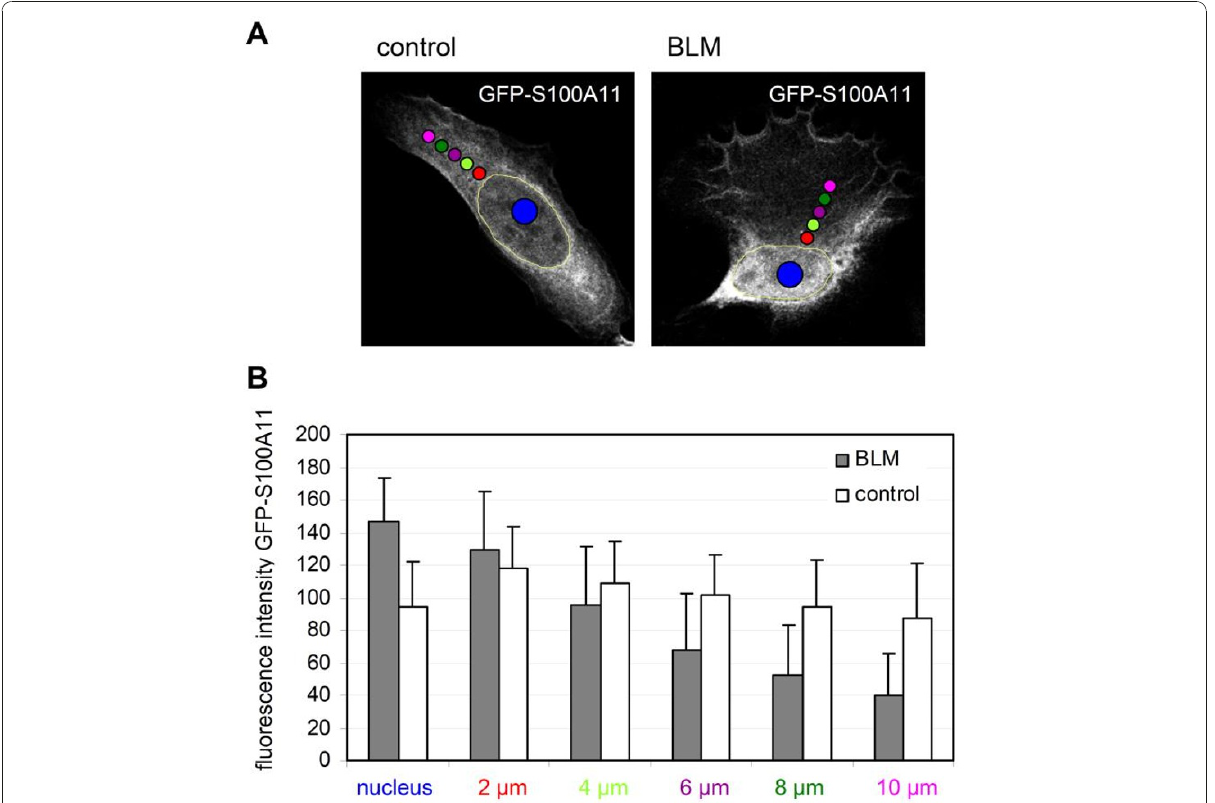
Figure 2 Quantification of S100A11 translocation in stress stimulated cells . The translocation of GFP-S100A11 in U-2 OS cells which were treated with BLM for 30 min to induce DNA double strand breaks (DSB) or in control cells was quantified by measurement of the average GFP- S100A11 fluorescence intensity in different areas within the cytoplasm as well as in the nucleus using MetaMorph analysis software as described in Materials and Methods. (A) The fluorescence intensity of GFP-S100A11 in five cytoplasmic areas (2 μ m diameter each; stained in red, light green, violet, green and pink, respectively) localized at the nuclear membrane to cellular periphery in four different directions based on the nuclear membrane as well as of three areas (5 μ m diameter each; stained in blue) randomly selected in the nucleus was measured radially. (B) Quantification of the GFP-S100A11 fluorescence signal in the cytoplasmatic areas and in nuclear areas of BLM-treated U-2 OS cells (n = 20) (grey column) or in control cells (n = 20) (white column). Data are displayed as mean values (±SD). Translocation of GFP-S100A11 in DNA damaged cells was significant between all examined